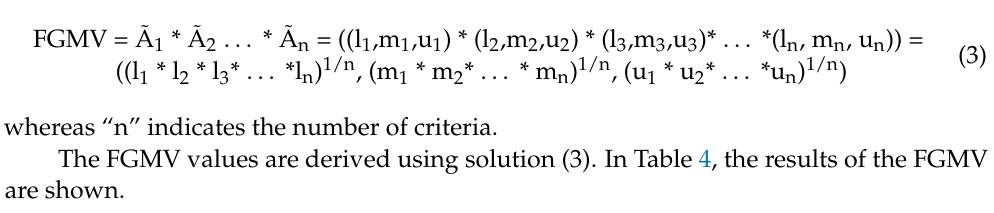
Table 4. Calculating